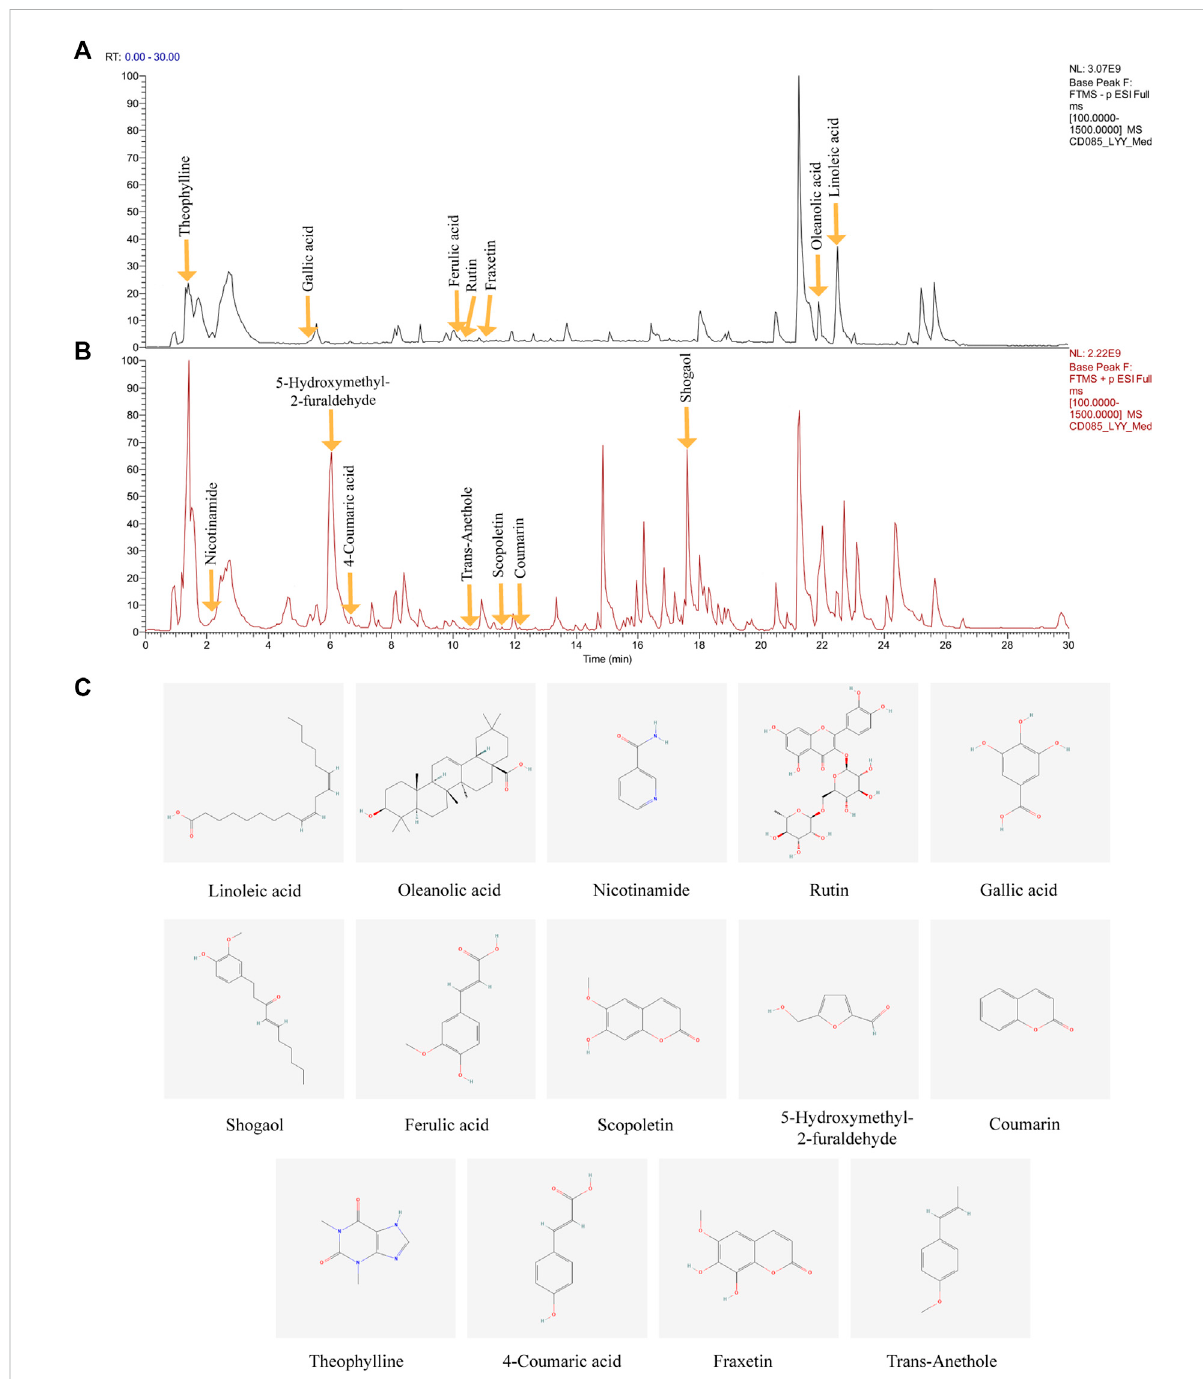
FIGURE 1 Identi fi cationofchemical componentsofHeidihuangWandecoction(HDHW).HDHWsampleswereexaminedbyUHPLC-Q-Orbitrap-MS/MS. Total ionchromatographyinnegative (A) andpositive (B) ionmodesfor HDHW samplesare shown. (C) Molecularstructure ofconstituents. UHPLC- Q-Orbitrap-MS/MS, Ultra High Performance Liquid Chromatography-Quadrupole-Electrostatic Field Orbitrap Tandem Mass